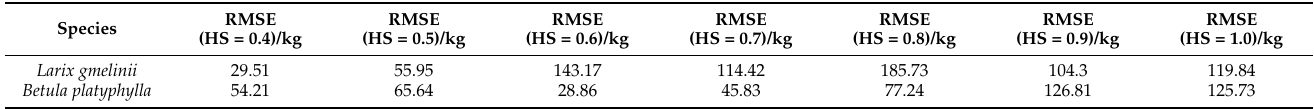
Table 4. Estimating AGB results of different tree species with different HS parameters in AdQSM.